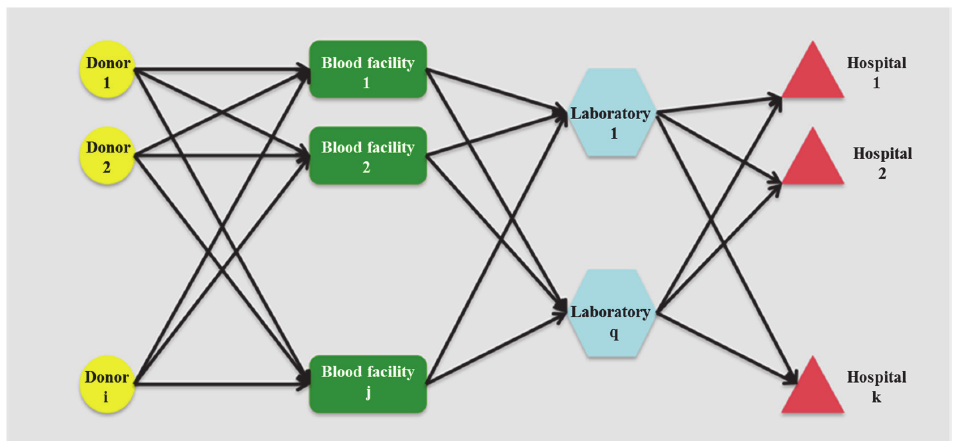
Fig. 1. Schematic form of blood supply chain